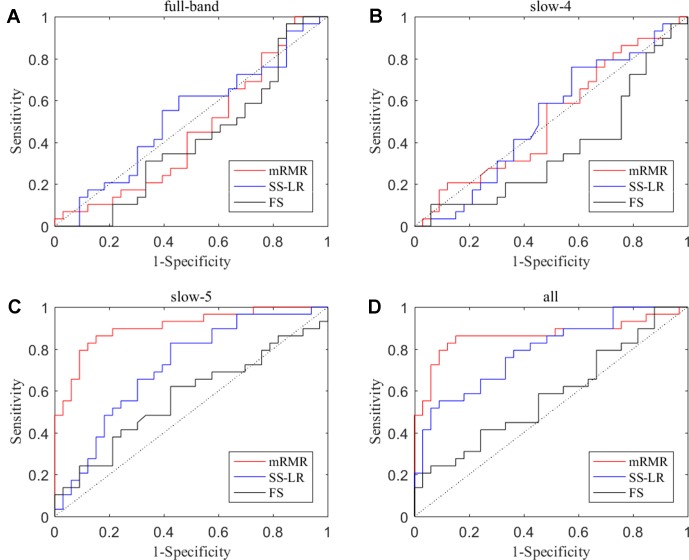
ROC curves for the three algorithms using the top 10 nodal features (A) full-band, (B) slow-4 band, (C) slow-5 band, and (D) all band.